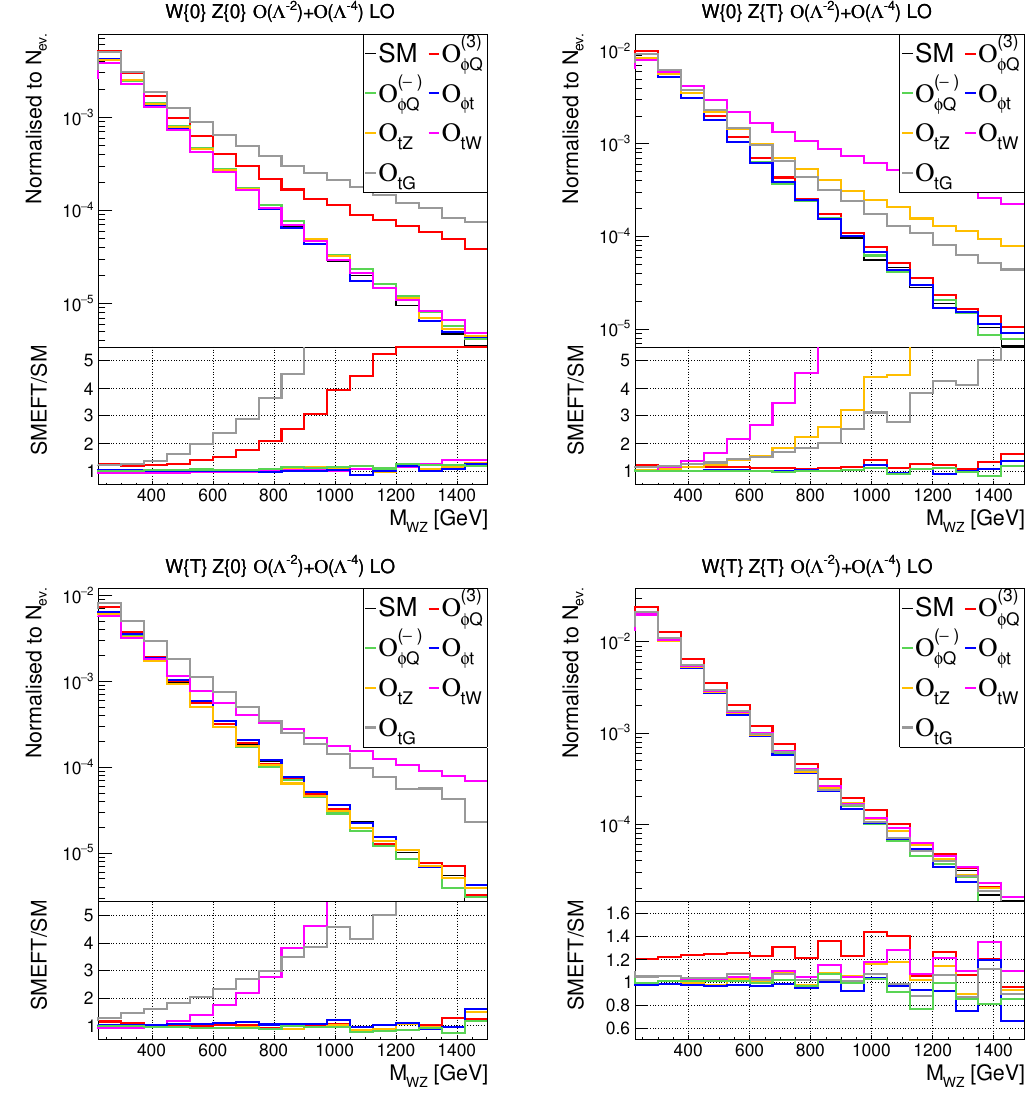
Figure 14 . Same as figure 6 but for the SMEFT predictions truncated at the quadratic-level ( O (Λ − 4 )